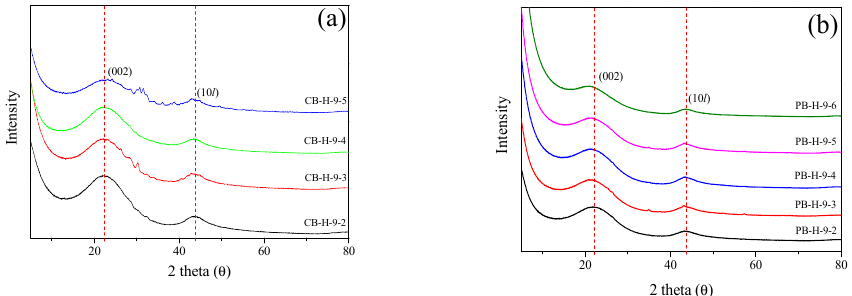
Figure 3. XRD patterns of bamboo-derived activated carbon as a function of various steam activation conditions: ( a ) CB-AC and ( b ) PB-AC.